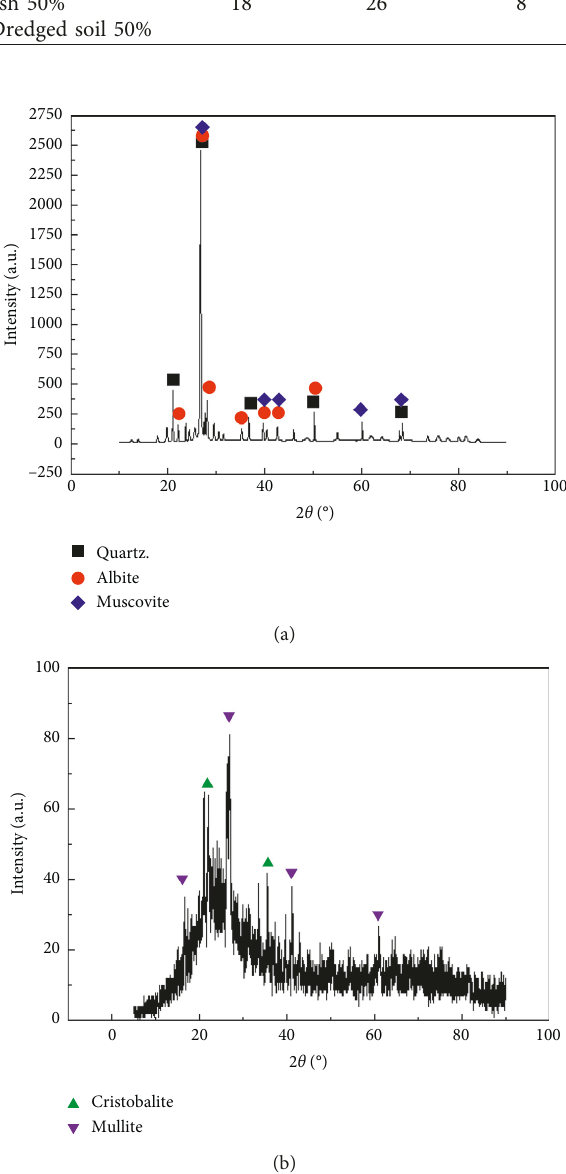
Figure 3: XRD analysis of raw materials. (a) Dredged soil. (b) Coal bottom